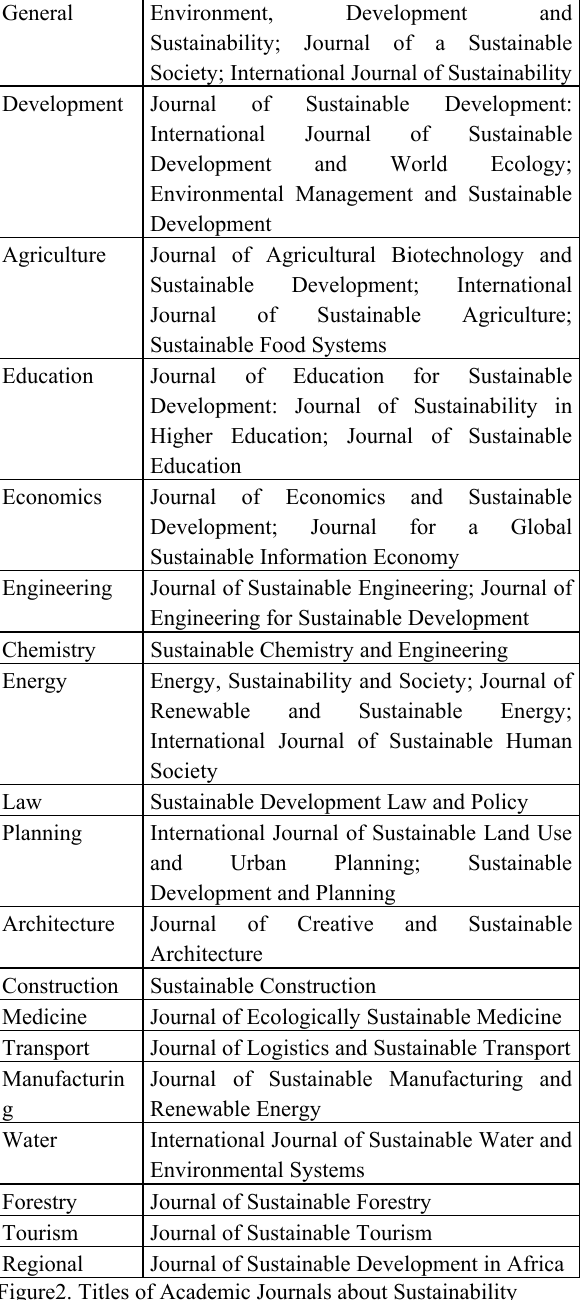
Figure2. Titles of Academic Journals about Sustainability (Source: Google Search Engine, Accessed 2 October